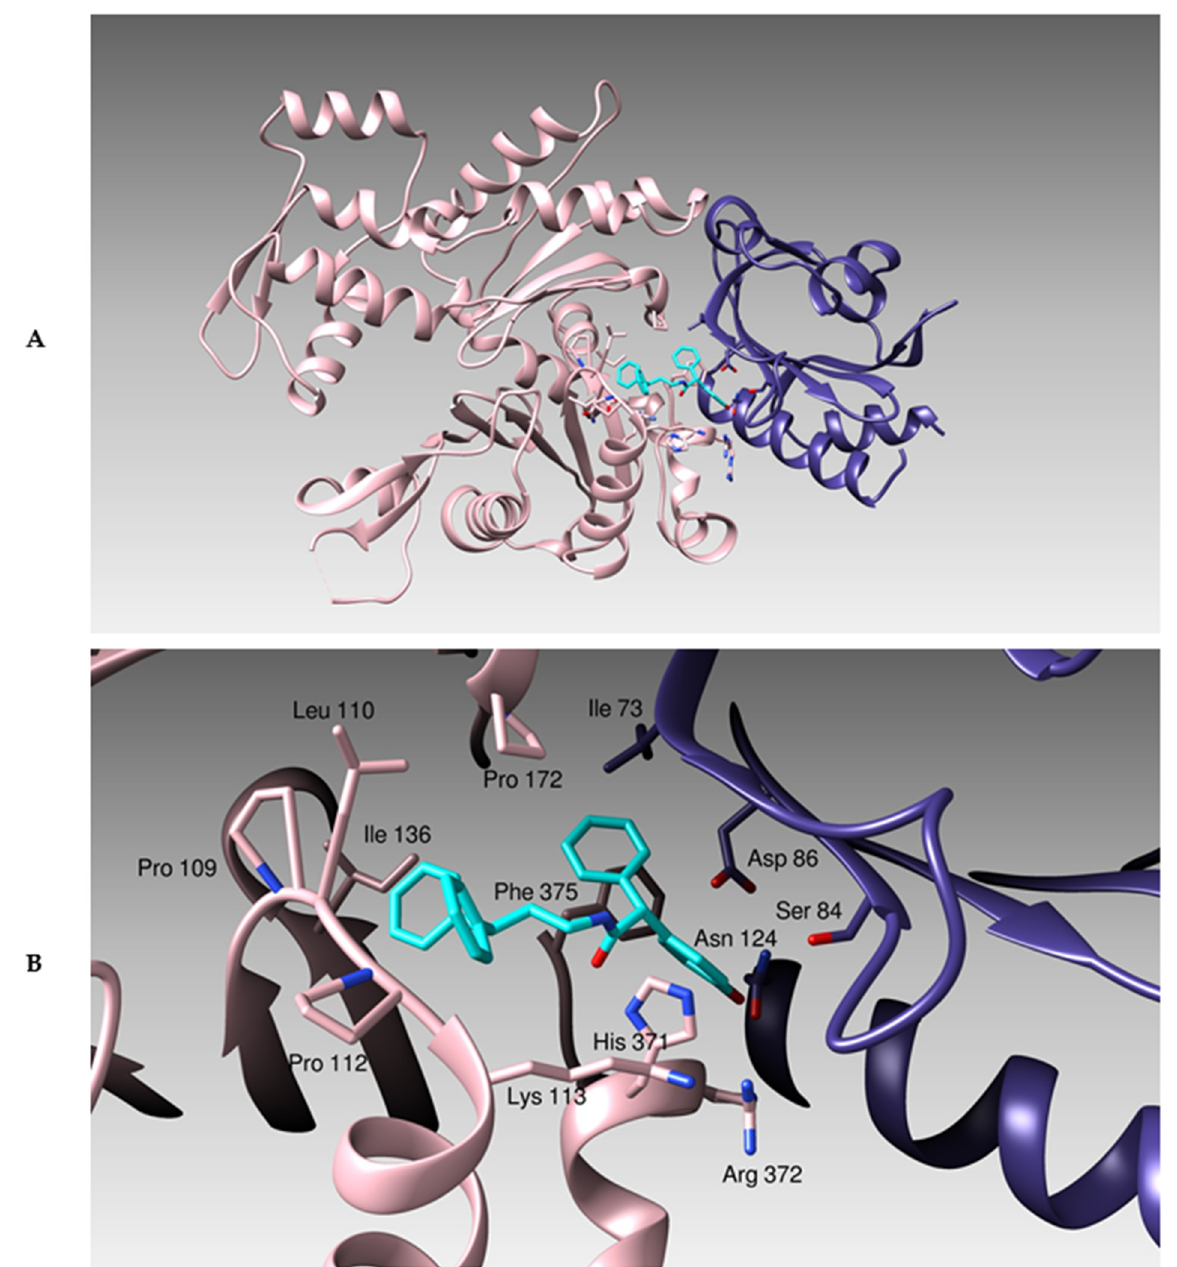
Figure 3. ( A ) A schematic view of the derivative 2 (drawn as cyan sticks) binding site located at the interface between actin (pink ribbons) and profilin (violet ribbons); ( B ) A detailed view of the interface between actin and Profilin allows to identify the different residues involved in the derivative 2